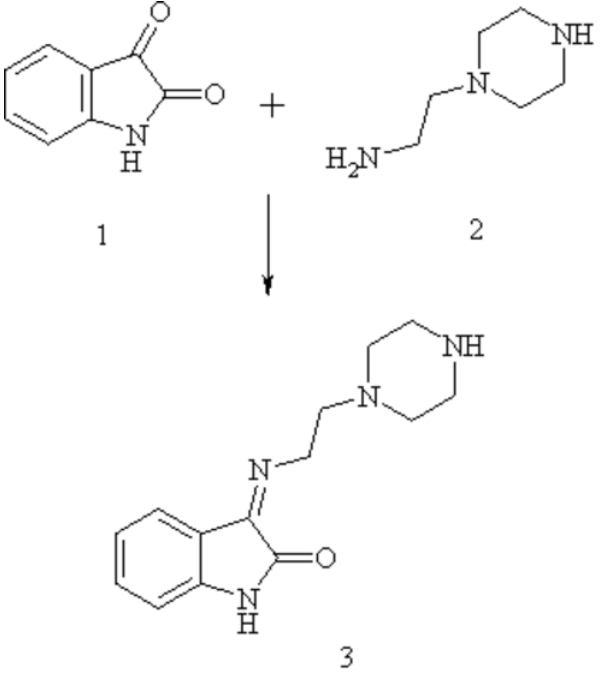
Melting point: 220 °